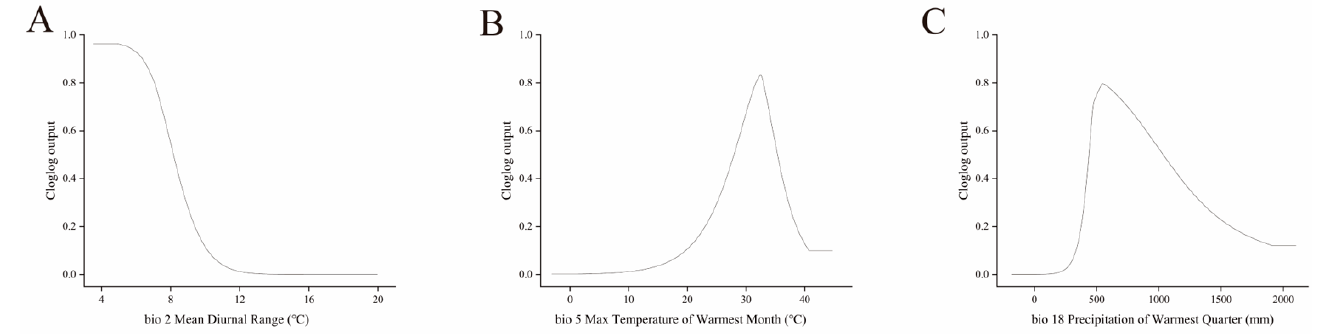
Figure 6. Response curve of the partial environment variables. ( A – C ) Respectively represent the response curves of mean diurnal range, max temperature of warmest month and precipitation of warmest quarter.